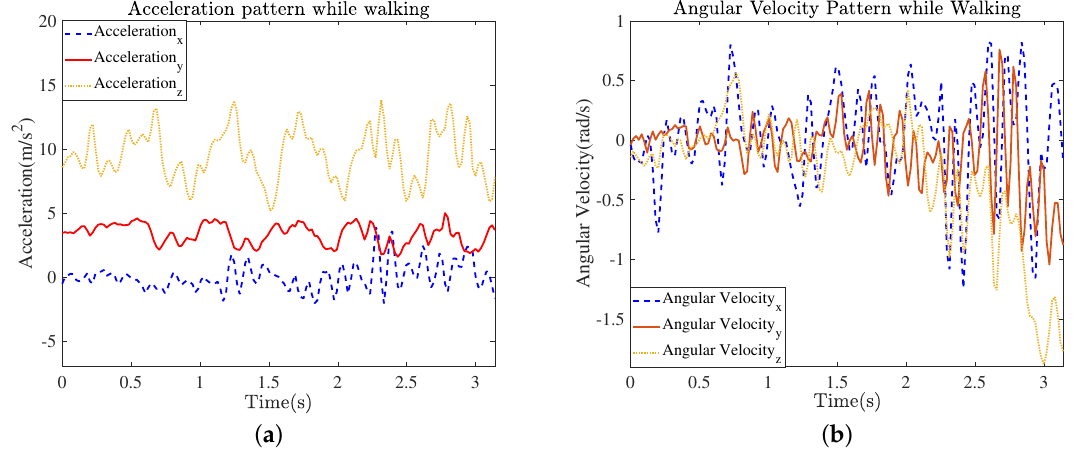
Figure 4. Signals of accelerometer and gyroscope sensors: signal patterns of ( a ) bodily acceleration and ( b ) angular velocity while walking.